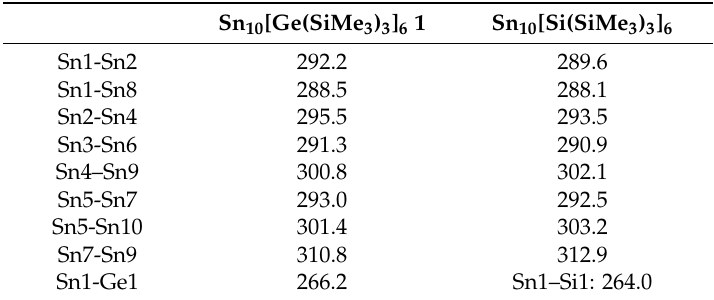
Table 1. Comparison of selected bond distances [pm] of the metalloid clusters Sn 10 [Ge(SiMe 3 ) 3 ] 6 1 and Sn 10 [Si(SiMe 3 ) 3 ] 6